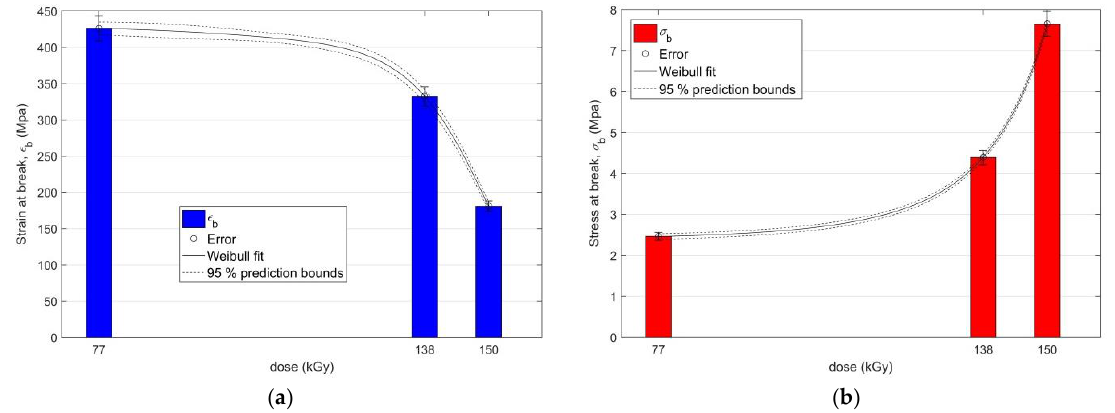
Figure 4. ( a ) Regression analysis of the functional dependence of strain at break ε b on the radiation